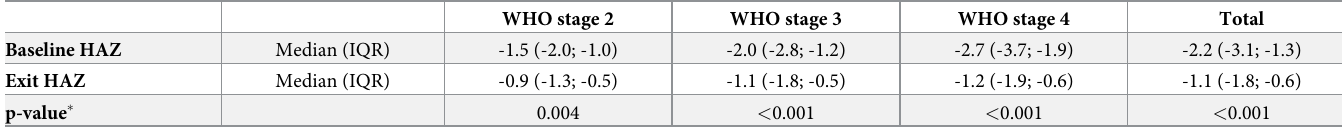
Table 3. Height-for-age evolution over time, stratified by clinical disease staging.